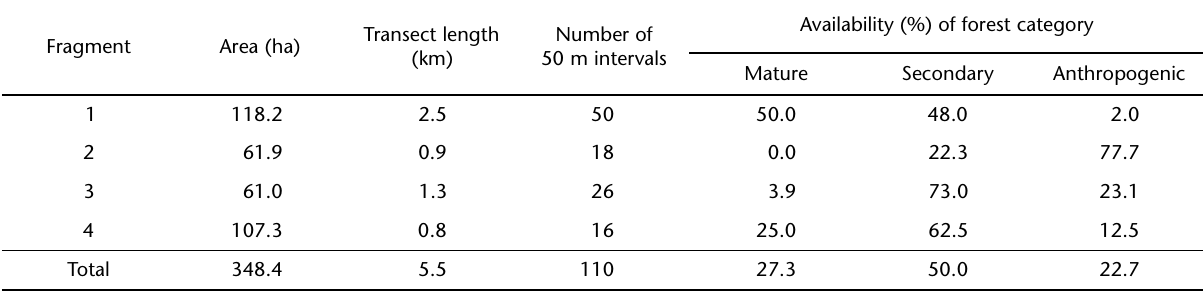
Table II. Estimated availability of the different habitats (Tab. I) in the four fragments surveyed during the present study.